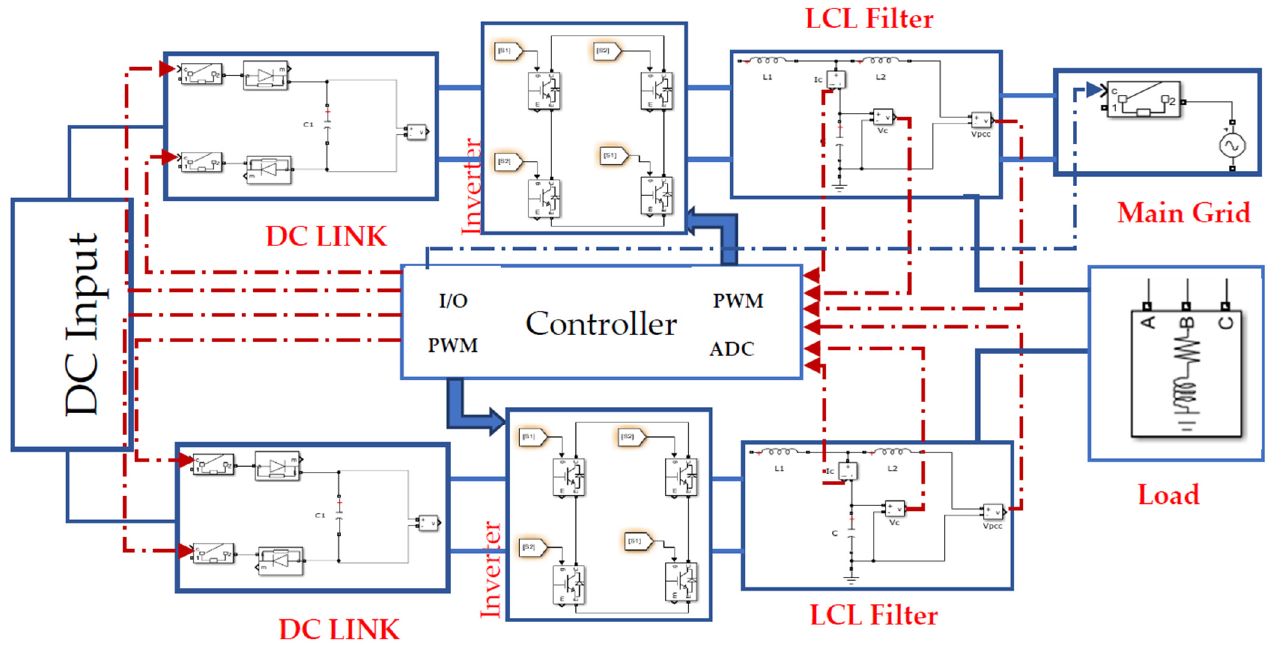
Figure 4. Schematic diagram of the